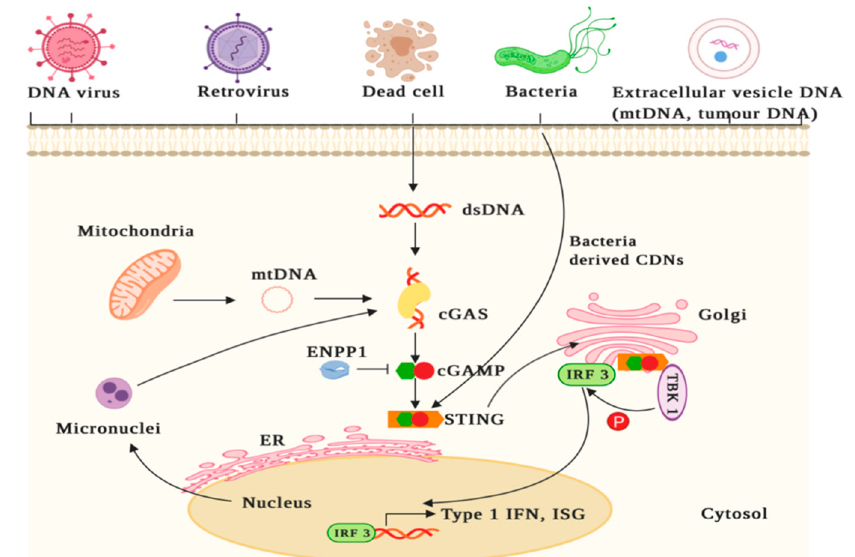
Figure 1. The cyclic guanosine monophosphate-adenosine monophosphate synthase-stimulator of interferon genes (cGAS-STING) signalling pathway. cGAS binds to the sugar-phosphate backbone of cytosolic double stranded (ds)DNA of a viral, apoptotic, exosomal,mitochondrial, or micronuclei nature, in a sequence-independent manner [21]. This binding results in conformational changes to cGAS which facilitates the catalysis of ATP and GTP into cyclic Gp(2 ′ ,5 ′ )Ap(3 ′ ,5 ′ ) (cGAMP) [22–24]. As an autoregulatory mechanism, cGAMP is degraded by ecto-nucleotide pyrophosphatase/phosphodiesterase 1 (ENPP1) [15,36,37]. STING is then activated by cGAMP at the endoplasmic reticulum (ER), resulting in its oligomerisation and tetramerization after which it translocates to the Golgi [25,26]. STING can also be directly activated by bacteria derived cyclic dinucleotides (CDNs) [27]. STING then recruits and activates TANK binding kinase 1 (TBK1) which phosphorylates the transcription factor interferon regulatory factor 3 (IRF3) [28,29]. Phosphorylated IRF3 then translocates to the nucleus and upregulates the expression of Type I interferons (IFNs) which results in the release of pro-inflammatory cytokines such as IFN- β [21,24]. This is an original figure created with BioRender.com.